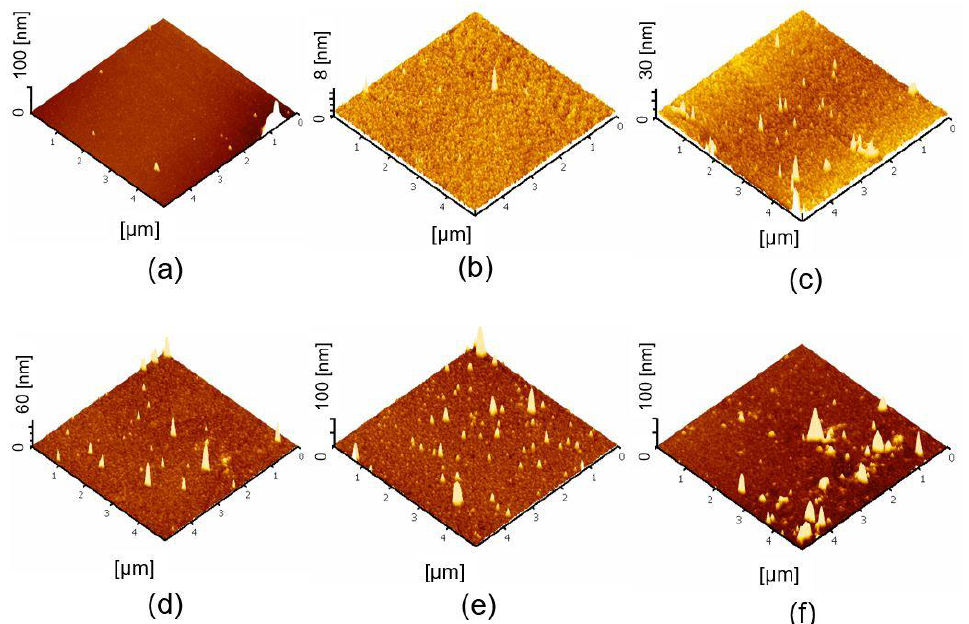
Figure 2. The surface topography analyzed by tapping mode AFM. ( a ) Bare Si 3 N 4 surface, ( b ) RCA-1-treated Si 3 N 4 surface, ( c ) APTES-modified Si 3 N 4 surface, ( d ) APTES-GA-modified surface, ( e ) 20 µ g/mL HLA-A-immobilized surface and ( f ) 20 µ g/mL MICA*010-immobilized